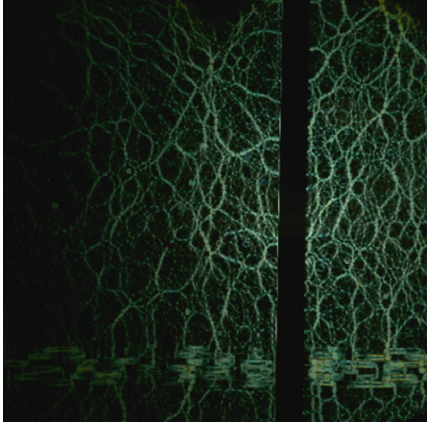
Figure 6: Force chains before excavation.